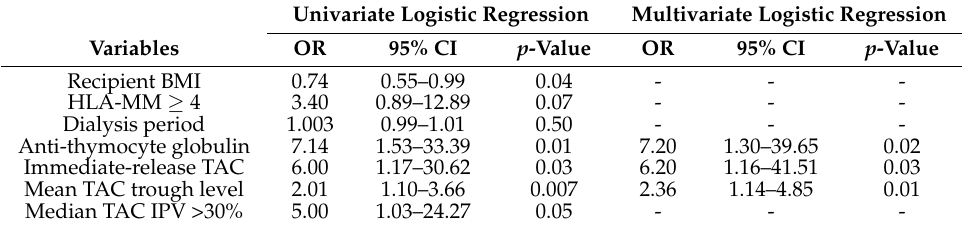
Table 2. Logistic regression analysis to evaluate risk factor for de novo AT1R-Ab development. Univariate Logistic Regression Multivariate Logistic